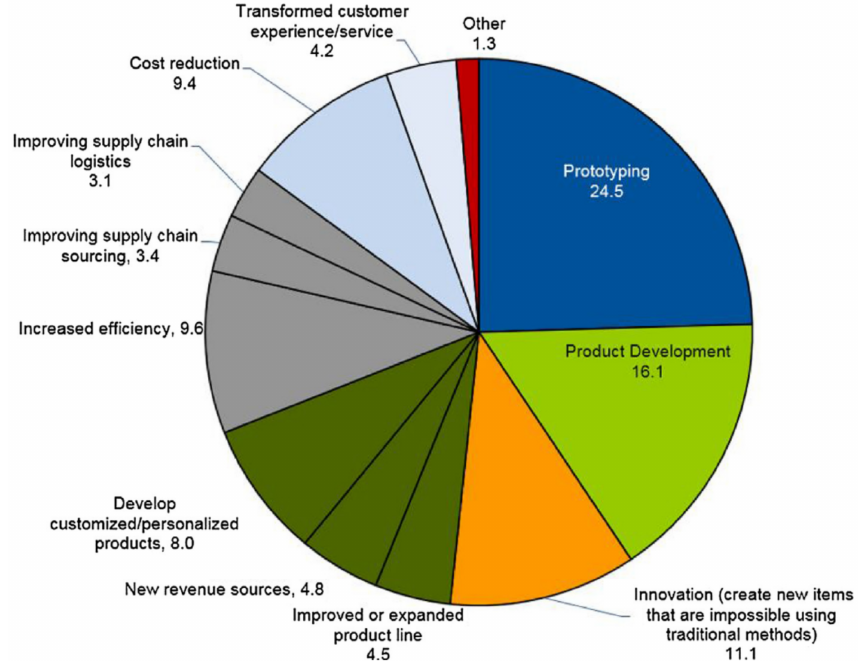
Figure 21. Contribution of 3D printing in various applications [27] Copyright 2018 with permission from